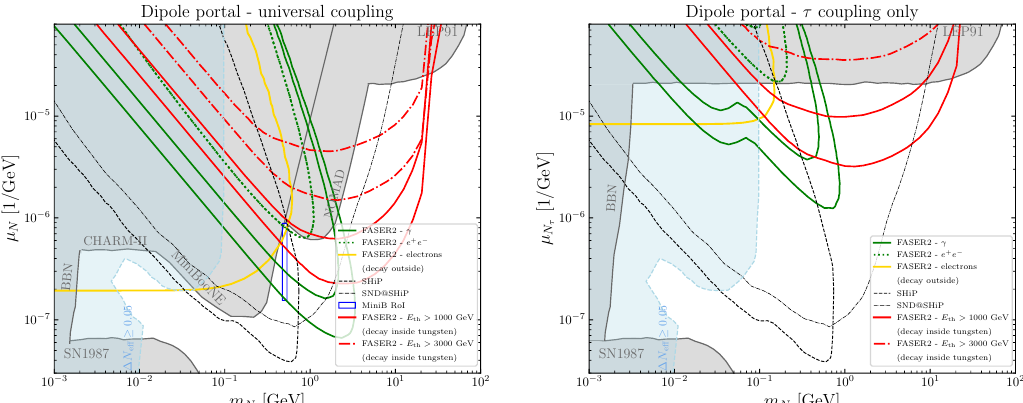
Figure 1 . The main result for the dipole portal model. In the left panel, we present the results for the model with the universal coupling to all of the neutrino flavors, while the right one corresponds to the model with the ν -specific coupling. The green solid lines denote the expected number of the τ signal events in FASER ν 2 during HL-LHC that involve high-energy photons appearing inside the decay vessel ( N = 3 , 30 ). The red solid (dash-dotted) lines correspond to such photons appearing ev in the ECC detector with the energy E 1 TeV ( E 3 TeV ). The yellow solid line represents γ > γ > the expected exclusion bound from the search for the electron scattering events. The gray-shaded regions denote current bounds on both models (see the text for details). The dark blue rectangle denotes the regions of interest in the parameter space relevant for explaining [24, 28] the origin of the MiniBooNE anomaly [71, 73]. The blue-shaded region corresponds to scenarios, in which the increased number of relativistic degrees of freedom in the early Universe predicted by the model could be used to relax the Hubble tension [38]. In the left panel, we also show the expected reach of the proposed SHiP experiment focusing on the search for single photons in the decay vessel (black dashed line) or in the SND@SHiP detector (black dash-dotted line extended towards larger HNL masses) following ref.